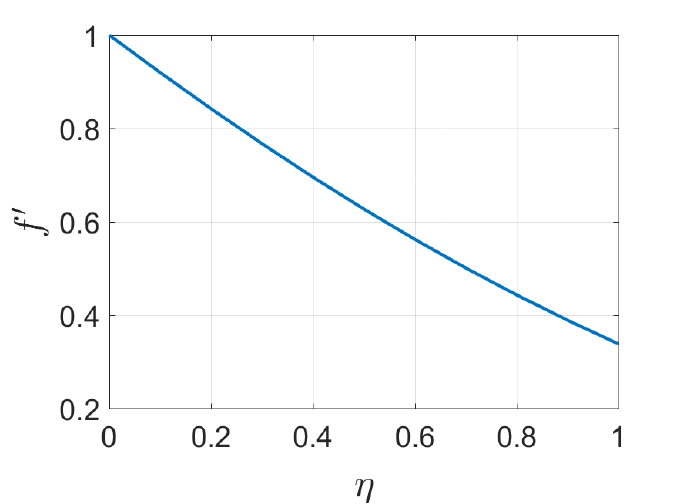
Figure 2. MHD Effects on velocity